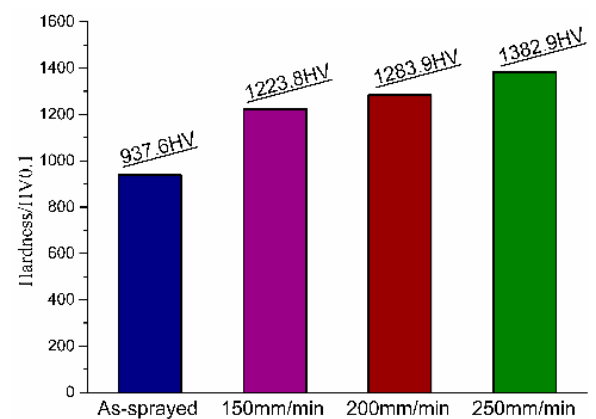
Figure 12. Average coating micro-hardness.